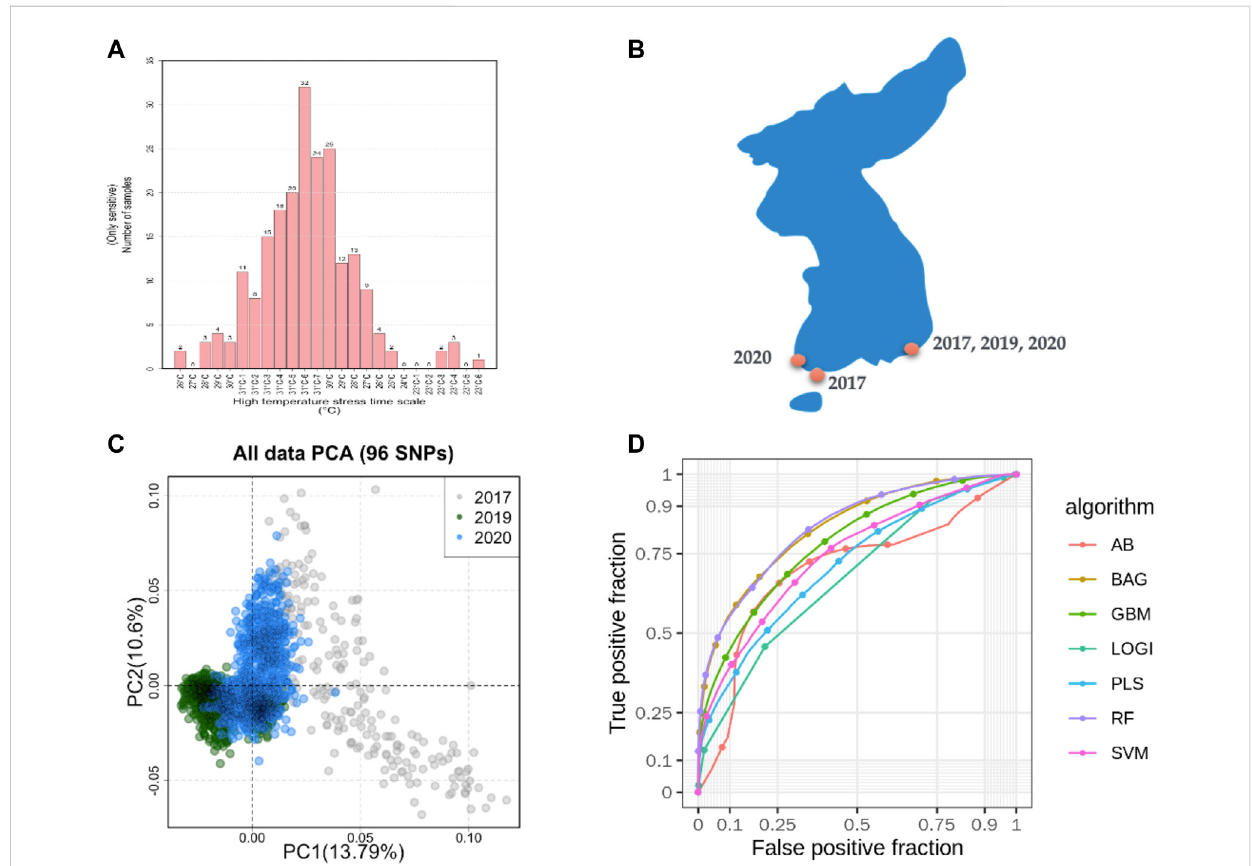
FIGURE 1 Sampling ofmachine learning predicted summaries. (A) .Heatresistanceexperimentfor sampleselectionand de fi ningtheclass ascase andcontrol. (B) . Sampling locations in South Korea. (C) . Sample diversity observed with 96 SNPs based on principal component analysis (PCA). (D) . Machine learning models predicted the accuracy from the pooled